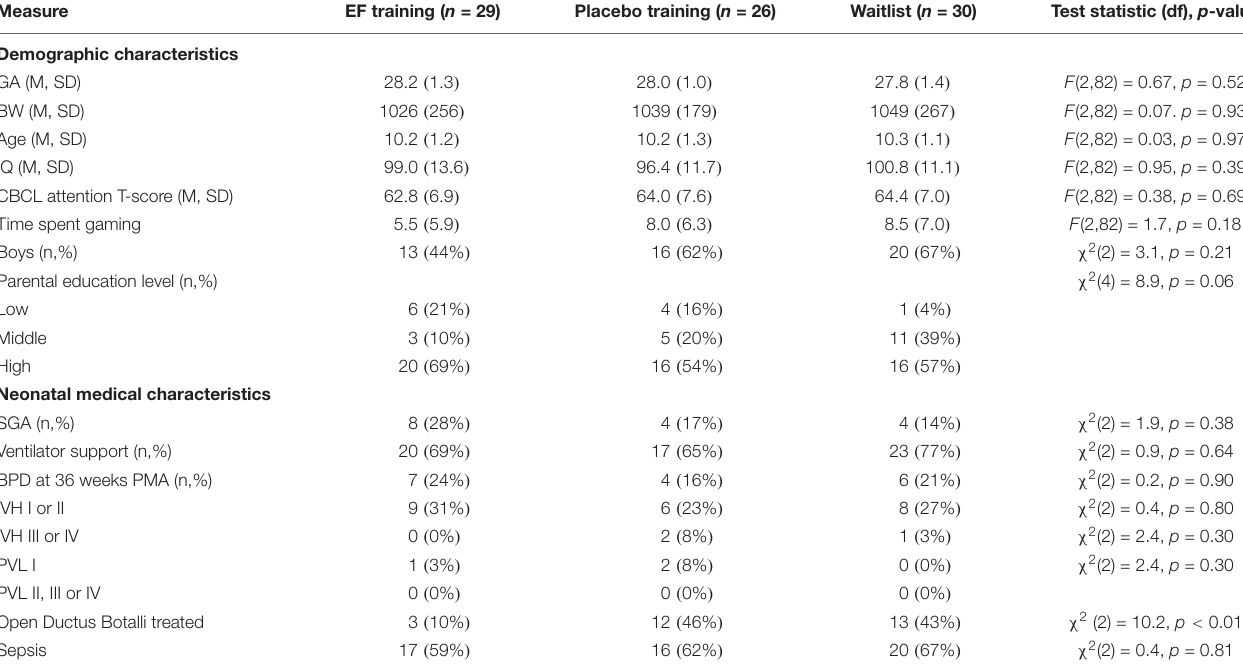
TABLE 1 | Demographic and neonatal medical characteristics for the three treatment groups.